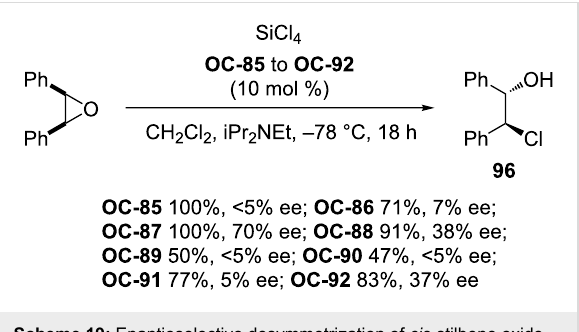
Scheme 19: Enantioselective desymmetrization of cis -stilbene oxide by using OC-85 to OC-92 as catalysts.